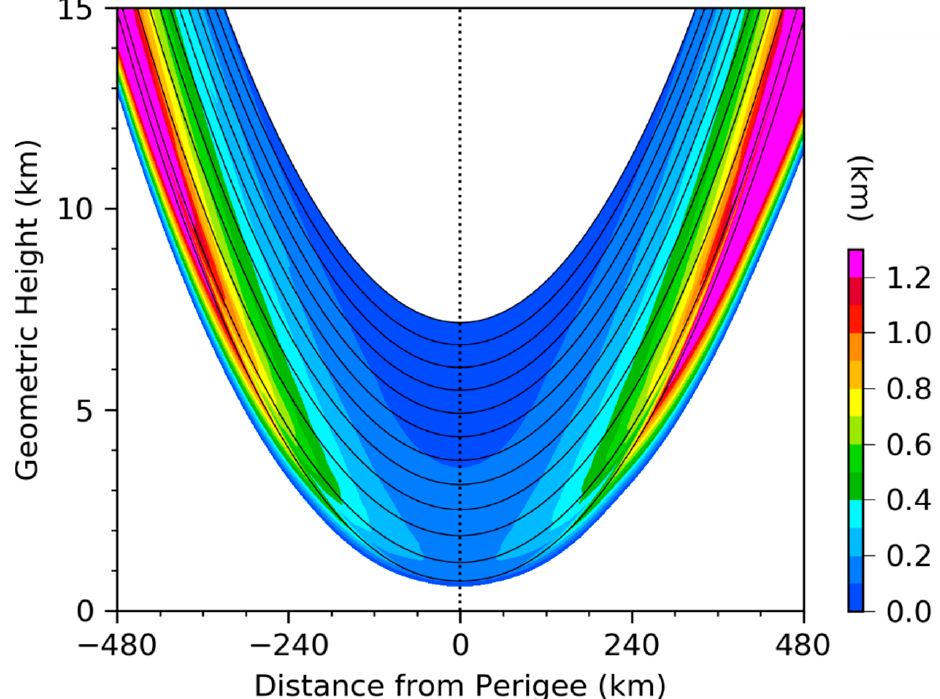
Figure 7. The means (black curves) and standard deviations (shaded in color) of the geometric heights of simulated ray paths within ±480 km horizontal distances from the perigee points for all 4627 RO simulations. The means and standard deviations are calculated for rays within each of the 100 m intervals of perigee height and 2 km intervals of horizontal distance.